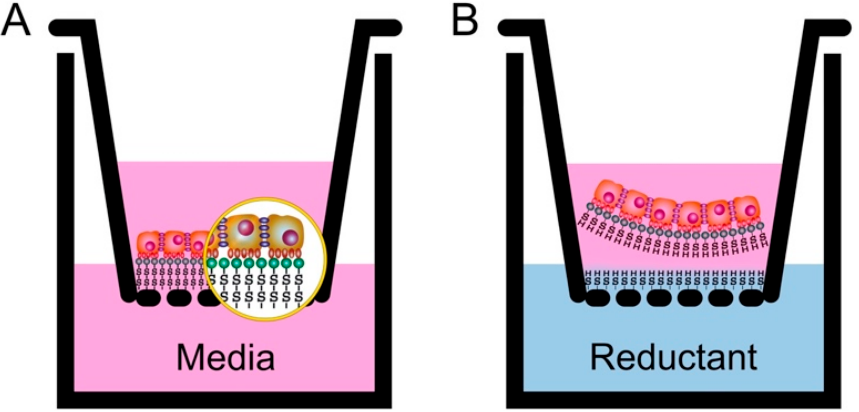
Figure 8. Illustration of the culture inserts and cell sheet detachment used for this study. ( A ): Cells were seeded in the culture insert until they reached the targeted thickness, which could largely vary according to the organ where the cell sheet was applied; ( B ): at the time of detachment, the culture medium inside the well was replaced by the reductant solution, which was used to cut the functional disulfide bonds between the bottom surface of the attached cell sheets and the inserts.